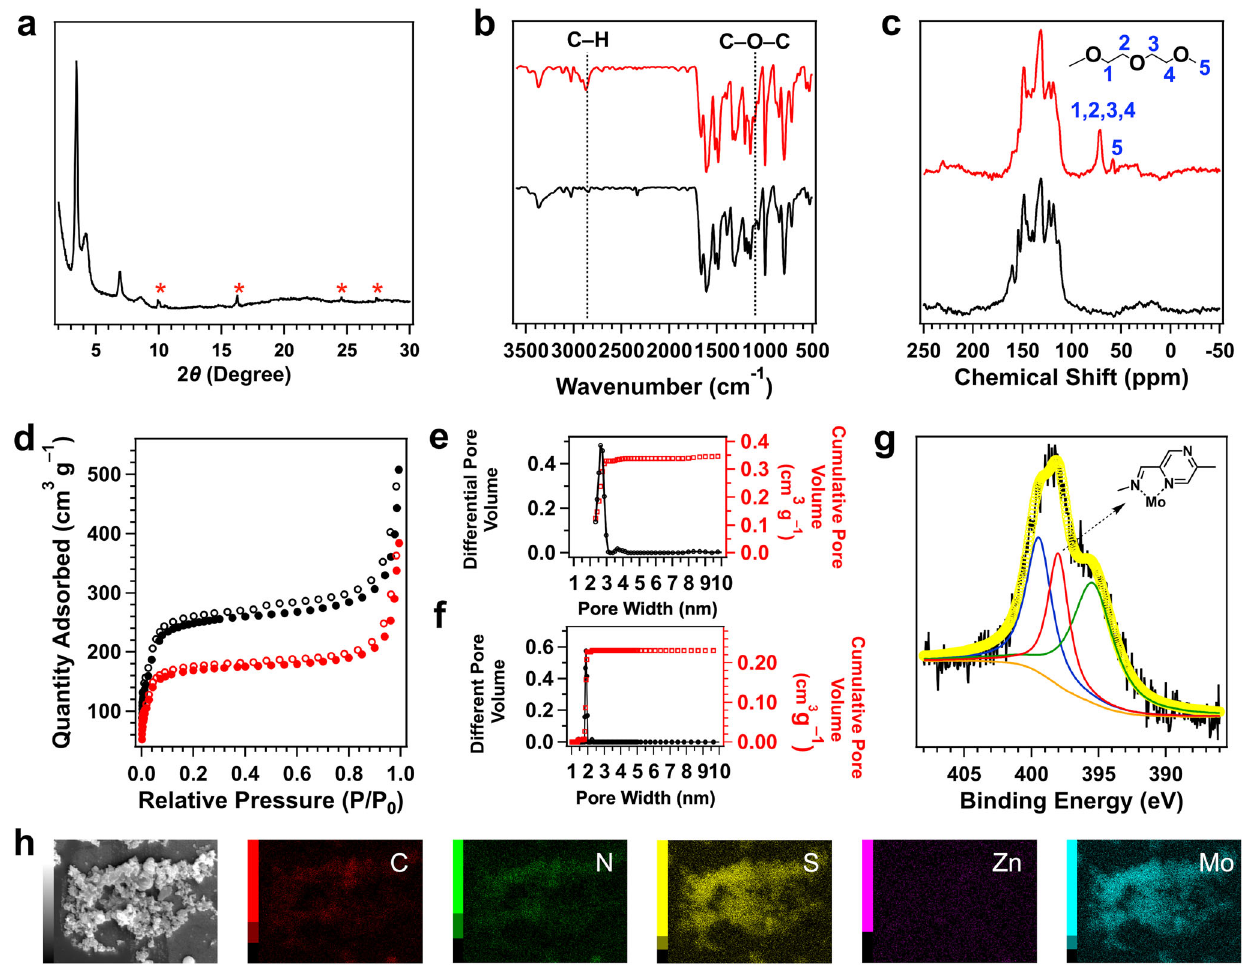
Fig. 3 | Characterisation. a PXRD pattern of [Mo 3 S 13 ] 2 – @ZnP-Pz-PEO-COF (peaks with red star due to [Mo 3 S 13 ] 2 – ). b FTIR spectra of ZnP-Pz-DHTP-COF (black curve) andZnP-Pz-PEO-COF(redcurve). c Thesolid-state 13 CCP/MASNMRspectraofZnP- Pz-DHTP-COF (black curve) and ZnP-Pz-PEO-COF (red curve). d Nitrogen sorption isotherm curves of ZnP-Pz-DHTP-COF (black circles) and ZnP-Pz-PEO-COF (red